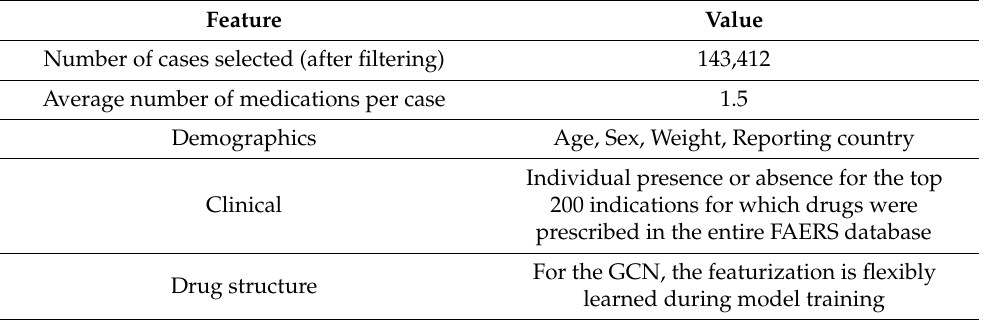
Table 2. Summary of key parameters of FAERS dataset.